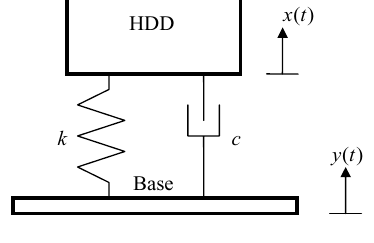
Fig. 6. HDD on vibration isolator mount.